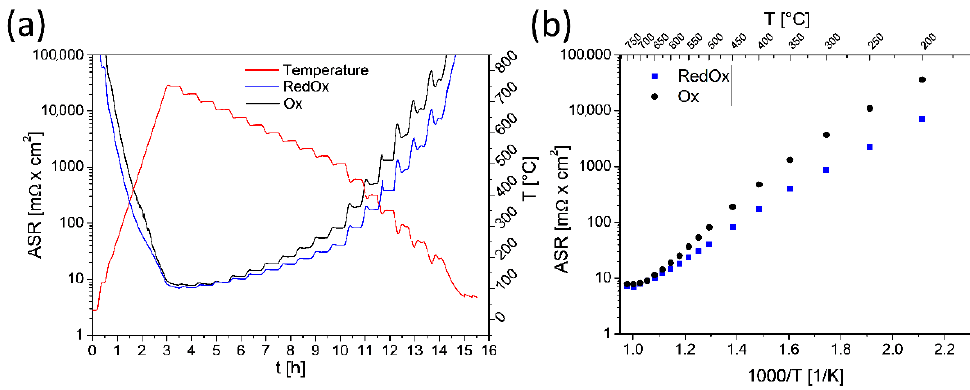
Figure 4. ASR measurement of the as-prepared 20s_Ox and 20s_RedOx samples: ( a ) as a function of time; ( b ) as a function of temperature.